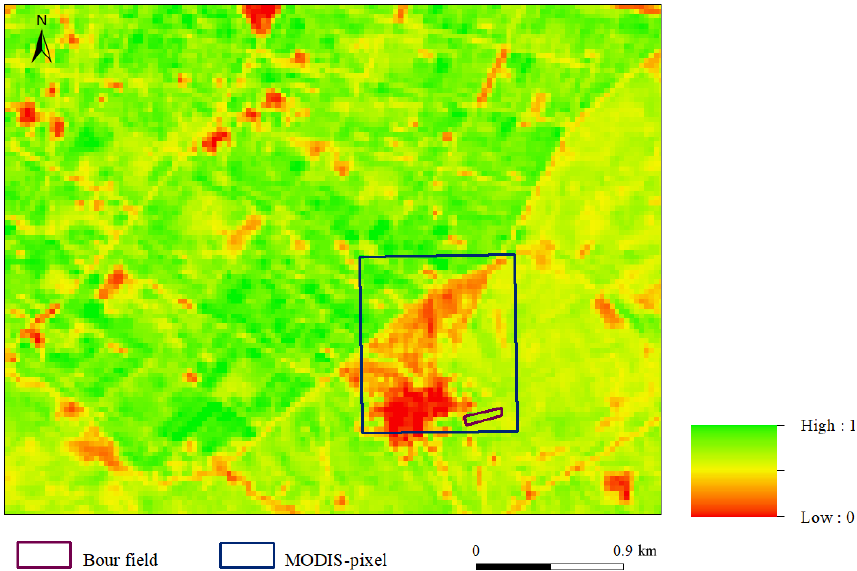
Figure 4. NDVI image derived from Landsat data acquired on 17 April 2018. The experimental field and the overlaying 1km resolution MODIS pixel are